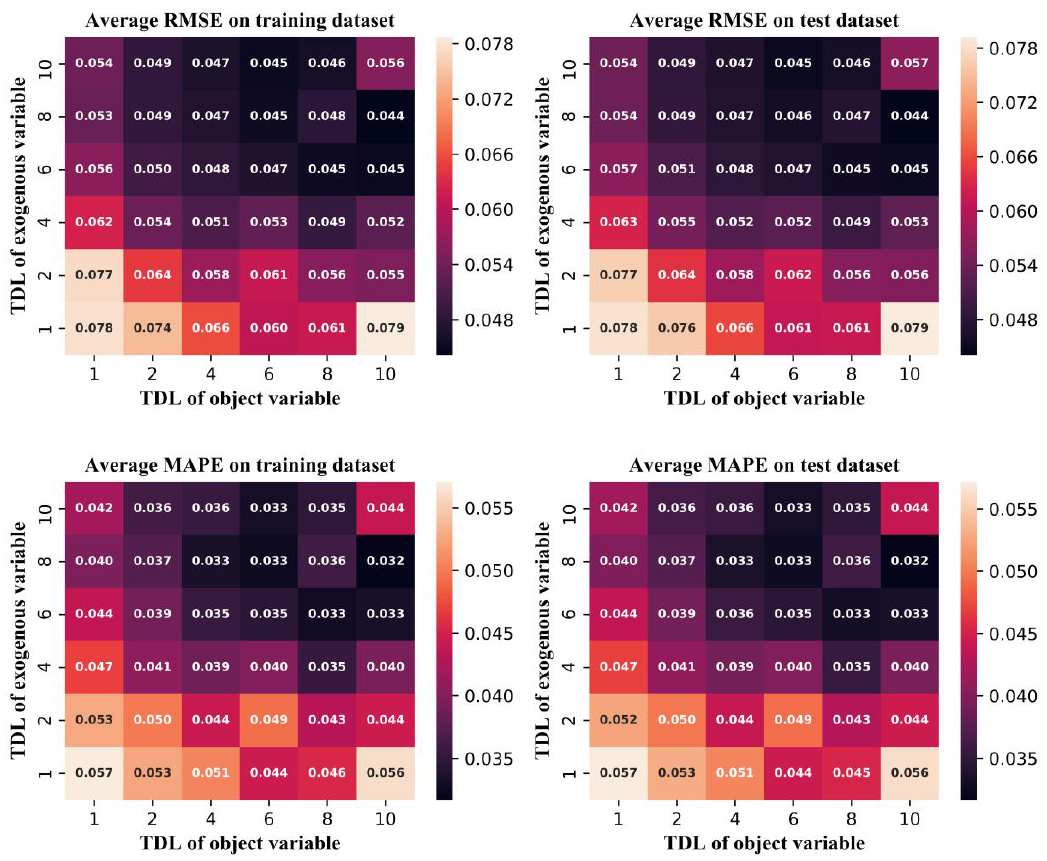
Figure 9. The performance of the principle components analysis- nonlinear autoregressive neural network with exogenous input (PCA-NARX) model for different combinations. Table 2. The comparison between LSTM-AE and PCA-NARX. RMSE on Training Dataset RMSE on Test Dataset MAPE on Training Dataset MAPE on Test Dataset